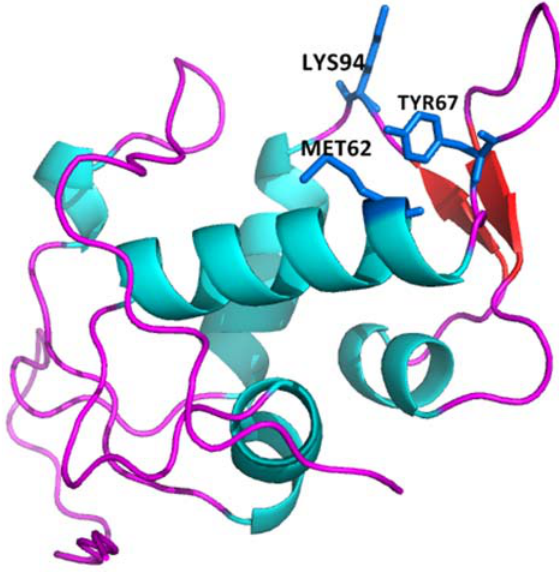
Figure 3: The essential paramount binding residues from MDM2 protein monomer that forms 50% of the interactions with DHFR protein.